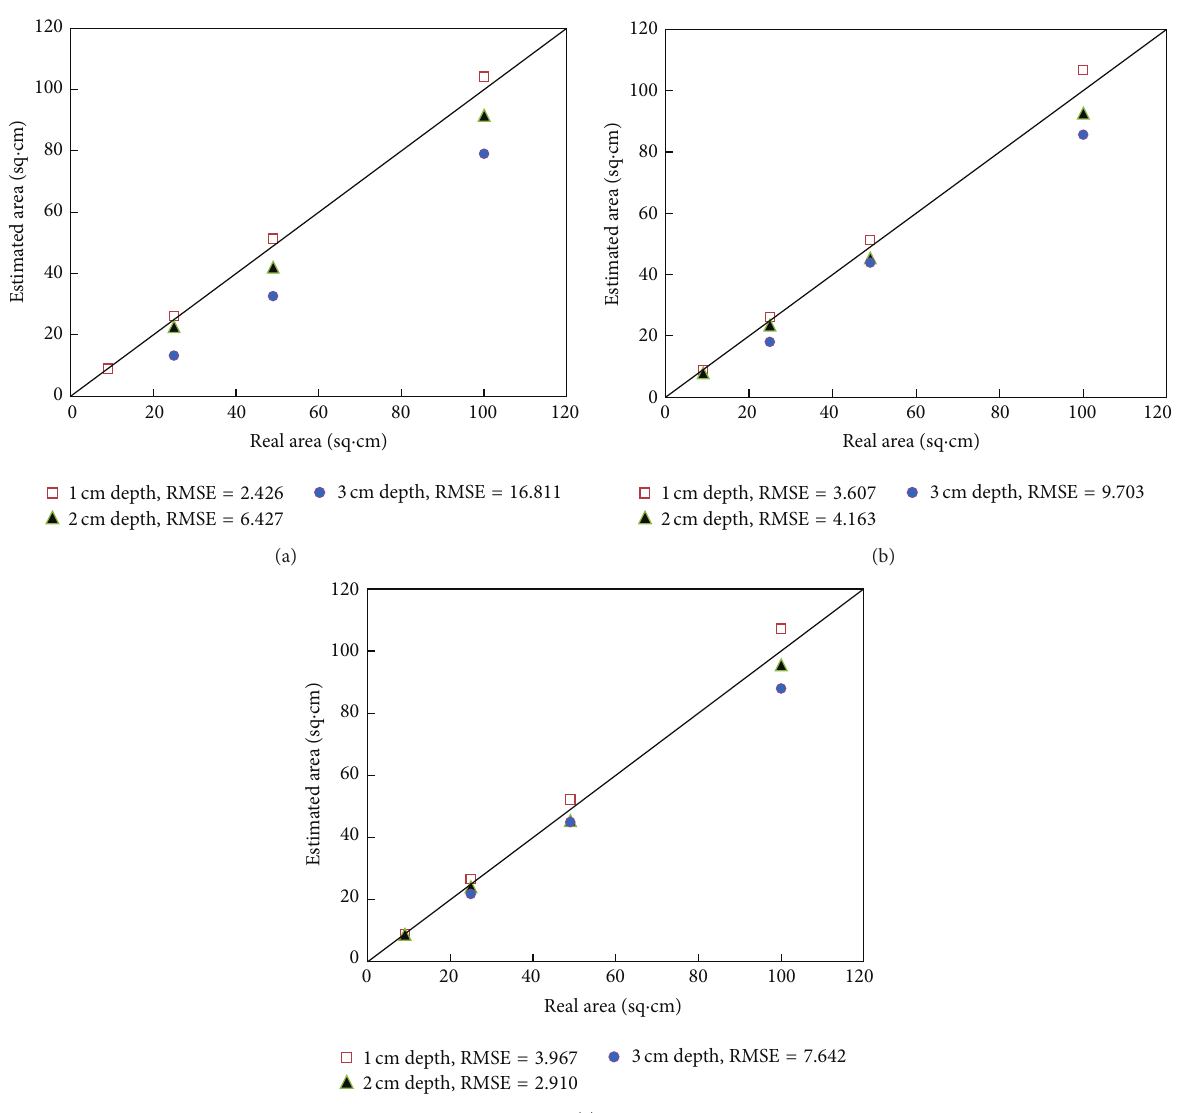
Figure 10: Comparison of the estimated and actual areas of the defects for the (a) 15-, (b) 20-, and (c) 25-minute heating cycles.